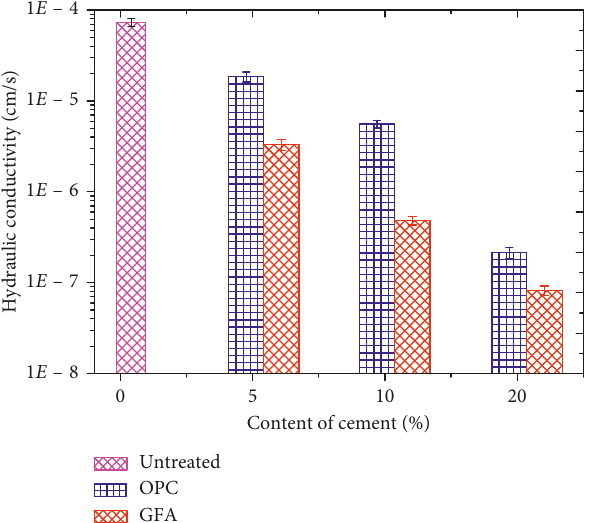
Figure 4: Pb concentration of the solidified/stabilized soils in the SBET